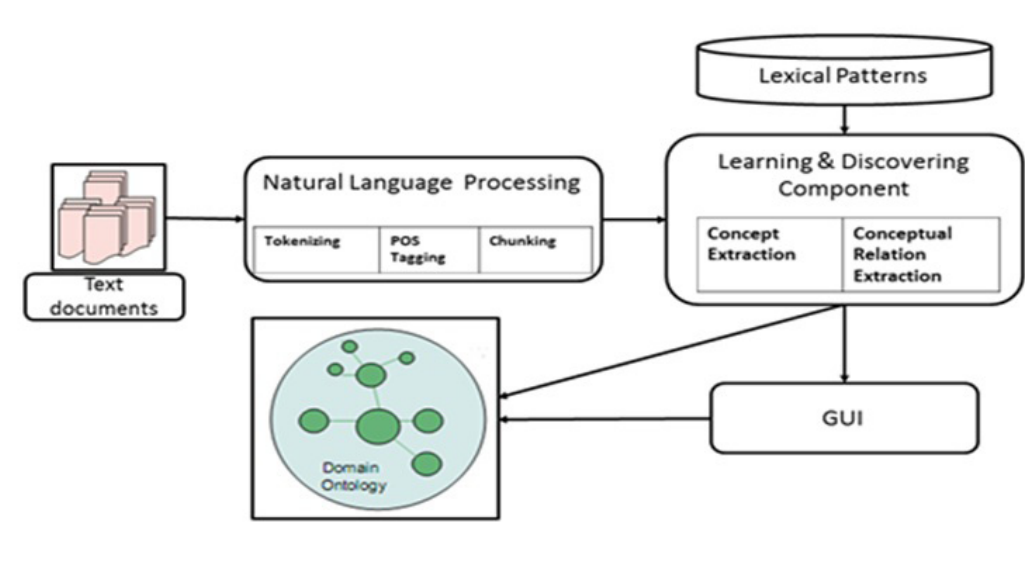
Figure 1. System